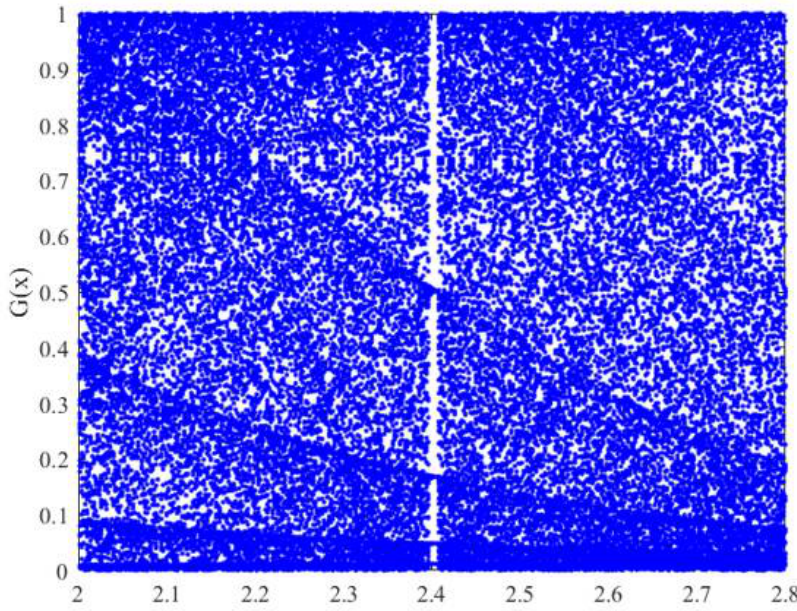
Figure 3. Bifurcation of the SET chaotic system when b = 0.8512.